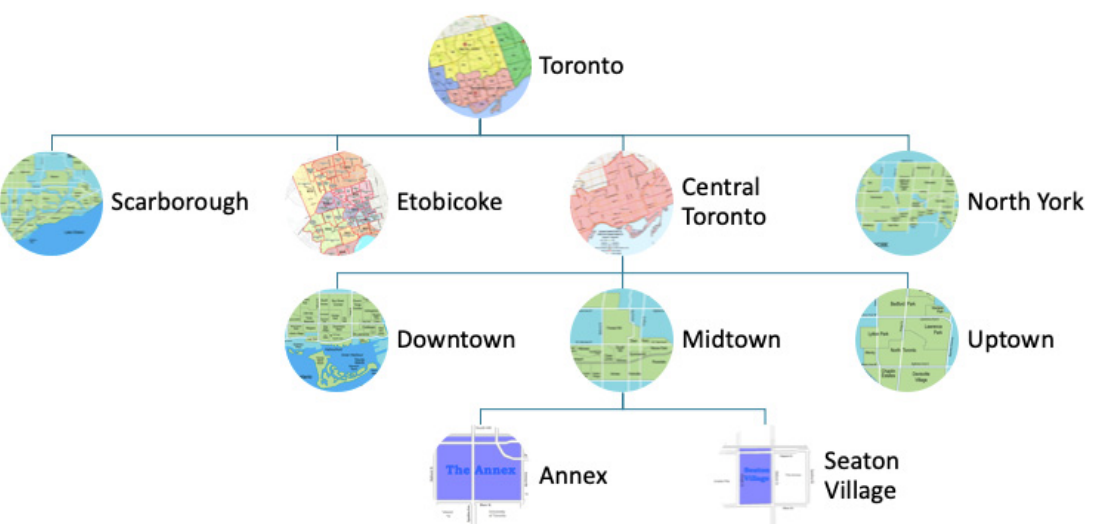
Figure 1. Hierarchical Aggregation of Spatial Areas in the City of Toronto.